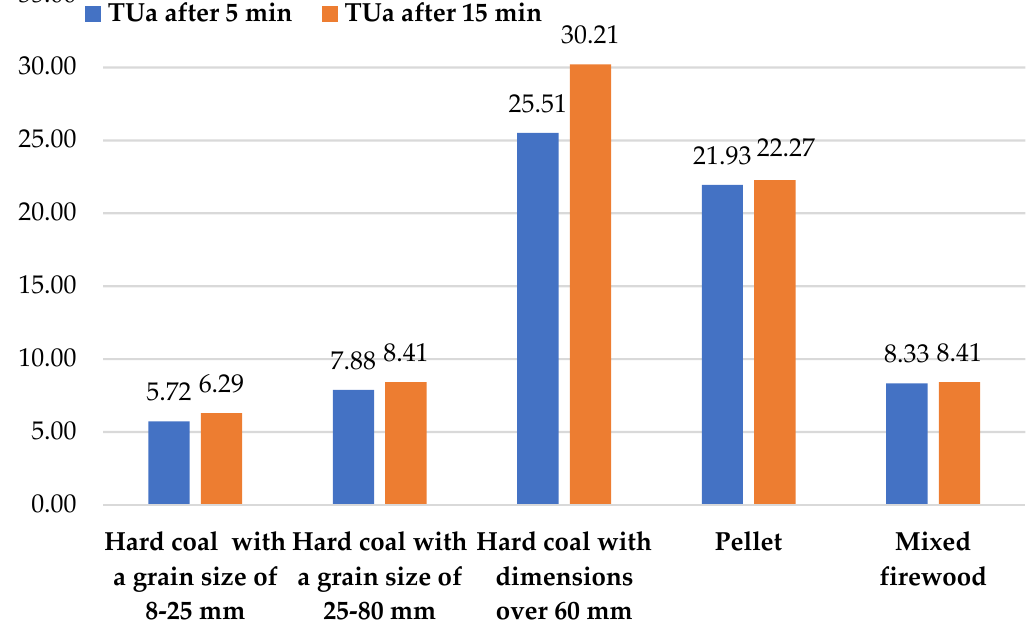
Figure 3. Comparison of the total PAHs, Σ LMW, and Σ HMW concentration in water extracts from soot generated by solid fuels combustion.